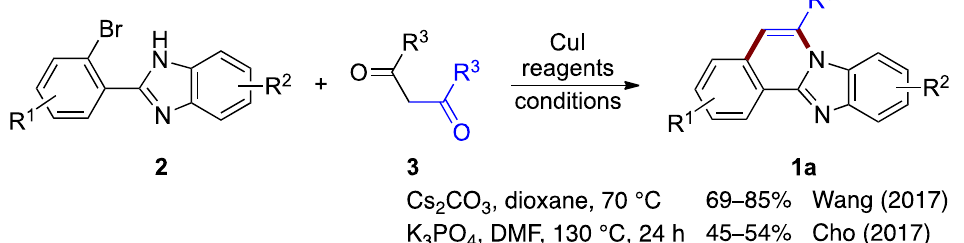
Figure 2. Copper(I)-catalyzed coupling protocols with o -bromophenyl benzimidazoles 2 and 1,3- diketones 3 [5,6].